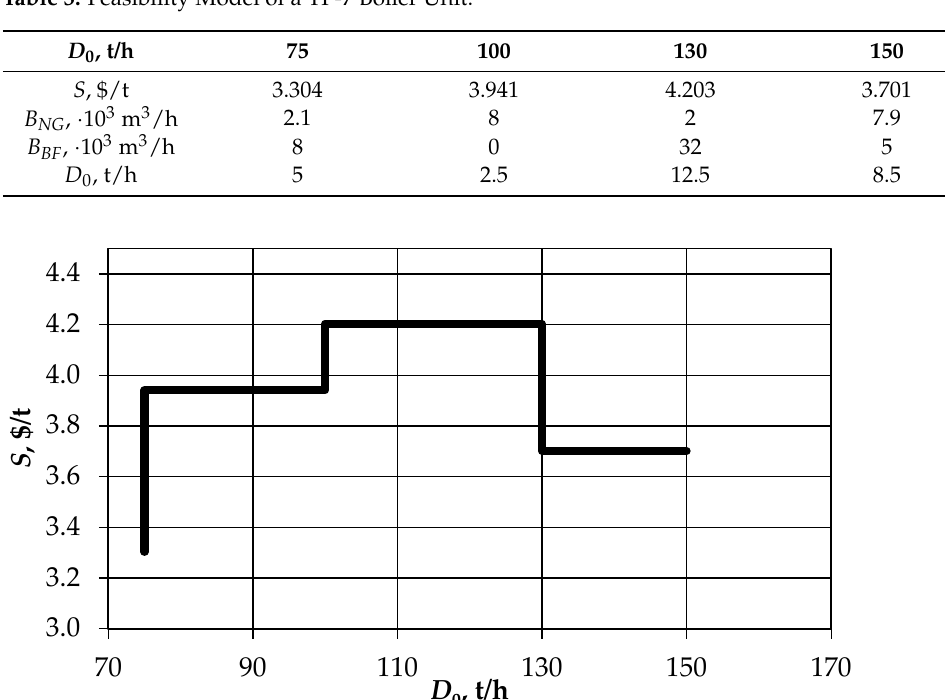
Figure 1. Example of a Feasibility Model of a TP-7 Boiler Unit.